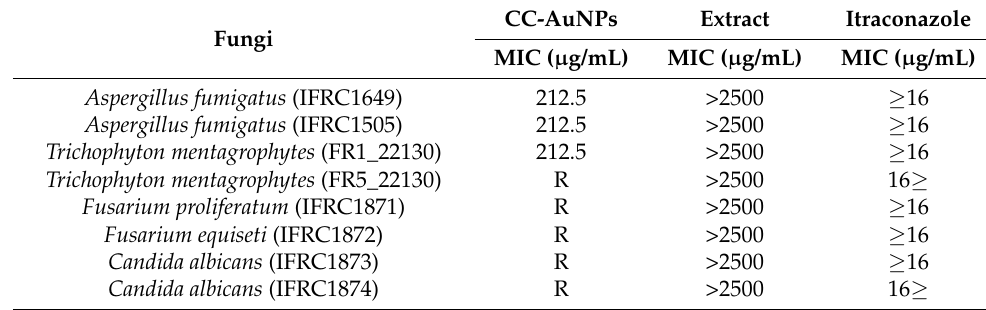
Table 3. The MIC value achieved from biosynthesized CC-AuNPs against fungi strains. CC-AuNPs Extract Itraconazole Fungi MIC ( µ g/mL) MIC ( µ g/mL) MIC ( µ g/mL) Aspergillus fumigatus (IFRC1649) 212.5 >2500 ≥ 16 Aspergillus fumigatus (IFRC1505) 212.5 >2500 ≥ 16 Trichophyton mentagrophytes (FR1_22130) 212.5 >2500 ≥ 16 Trichophyton mentagrophytes (FR5_22130) R >2500 16 ≥ Fusarium proliferatum (IFRC1871) R >2500 ≥ 16 Fusarium equiseti (IFRC1872) R >2500 ≥ 16 R >2500 ≥ 16